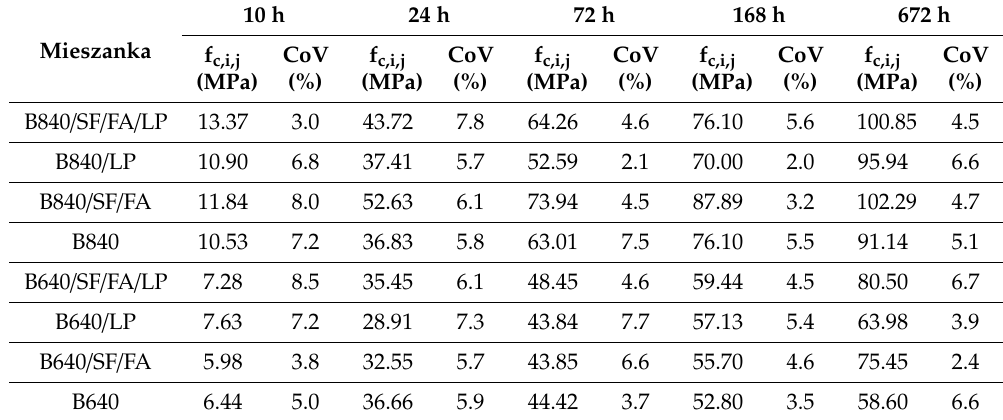
Table 3. Detailed results of the compressive strength of concrete.